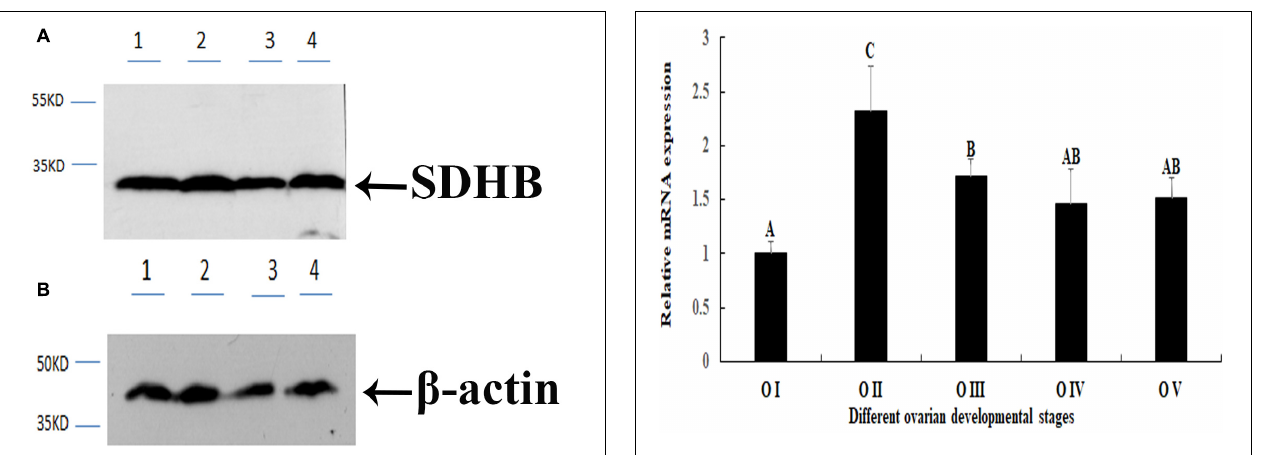
FIGURE 5 | Western-blot analysis in testis and androgenic gland from reproductive season and non-reproductive season. (A) Western-blot for SDHB. (B) Western-blot for B-action. Line 1: Testis from the non-reproductive season; Line 2: Testis from the reproductive season; Line 3: Androgenic gland from the non-reproductive season; Line 4: Androgenic gland from the reproductive season. B-action was used as reference gene.